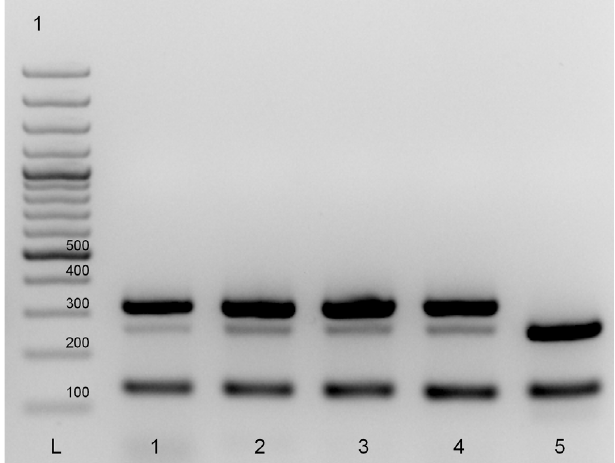
Figure 1. Electrophoretic pro fi les of Trichinella murrelli and T. britovi larva amplicons after multiplex PCR ampli fi cation.DNA extracts from 1 and 10 larvae of T. murrelli (isolate code ISS35) in lane 1 and lanes 2 – 4, respectively; and of T. britovi (isolate code ISS235) larva in lane 5. Lane L1=100 bp